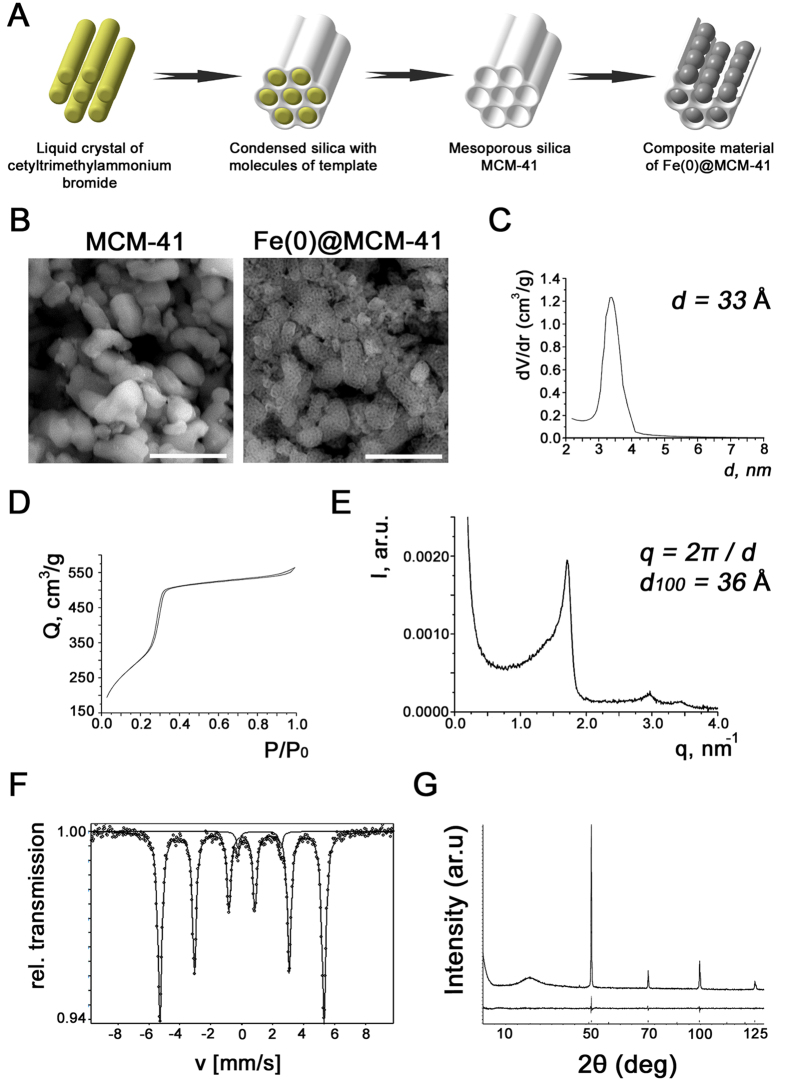
Synthesis and characterization of the Fe(0) @ MCM-41 nanoparticles.(A) Schematic representation of Fe(0) @ MCM-41 synthesis. (B) SEM images of the MSNs and zero-valent Fe impregnated particles. Scale bar, 100 nm. (C) Differrential distribution curve of pores in the Fe(0) @ MCM-41 particles. (D) Nitrogen isotherm of the calcinated MSNs sample. (E) Energy dispersive X-ray (EDX) spectra of Fe(0) @ MCM-41. (F) Mössbauer spectra of Fe-MSNs particles. (G) X-ray difractometry pattern of Fe(0) @ MCM-41 nanoparticles.